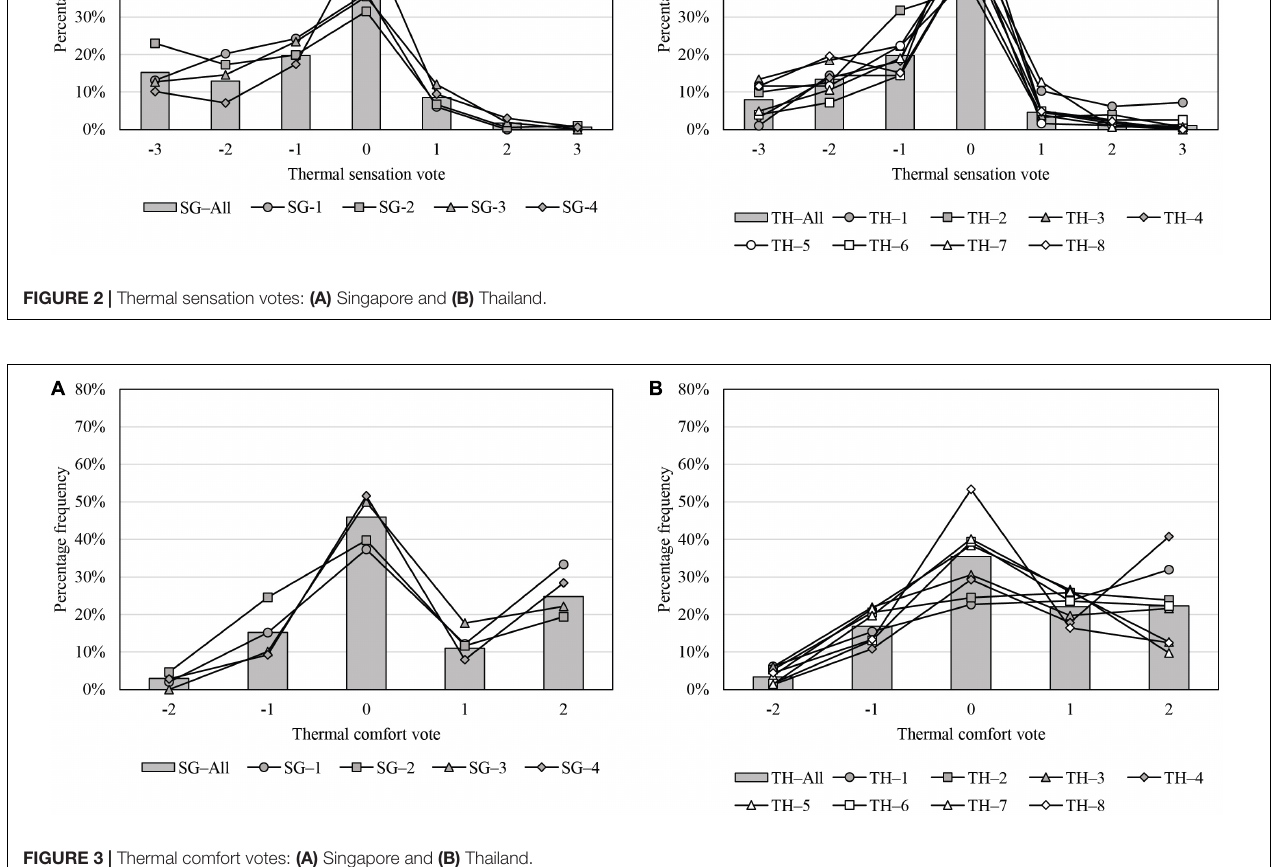
FIGURE 3 | Thermal comfort votes: (A) Singapore and (B) Thailand.